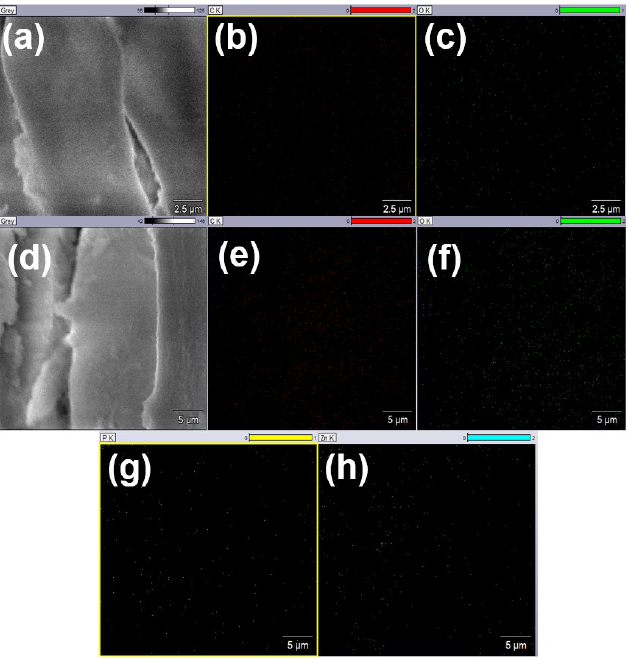
Figure 4. ( a ) SEM image and ( b,c ; displaying mapping of C and O ) EDS mapping of untreated cotton hand embroidery threads. ( d ) SEM image and ( e – h ; displaying mapping of C, O, P and Zn ) EDS mapping of treated cotton hand embroidery threads, displaying a good dispersion of ZnONPs.